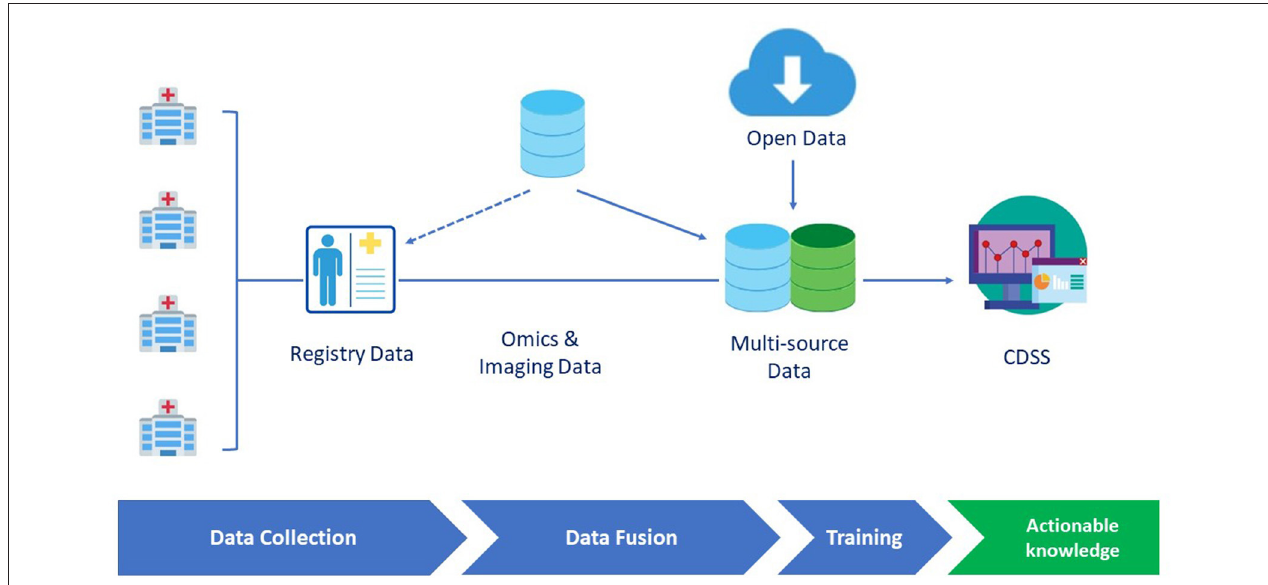
FIGURE 1 | A prototypical data flow pipeline in the clinical decision support system (CDSS) dedicated to rare diseases (RDs). Omics and imaging data can either be integrated from different sources or be collected as part of disease registry data. Data are then fed to the learning engine and the results are provided through a CDSS GUI